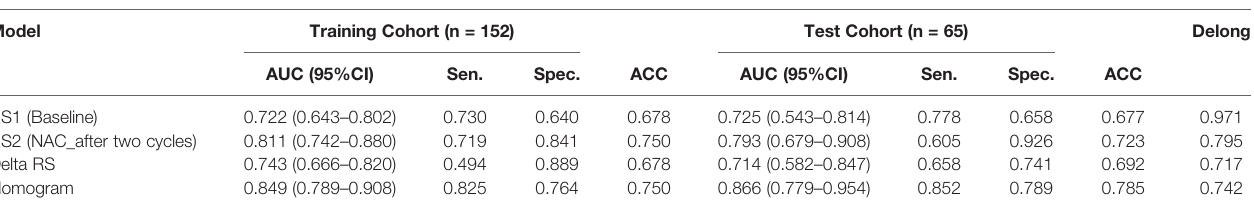
TABLE 3 | Comparison of different